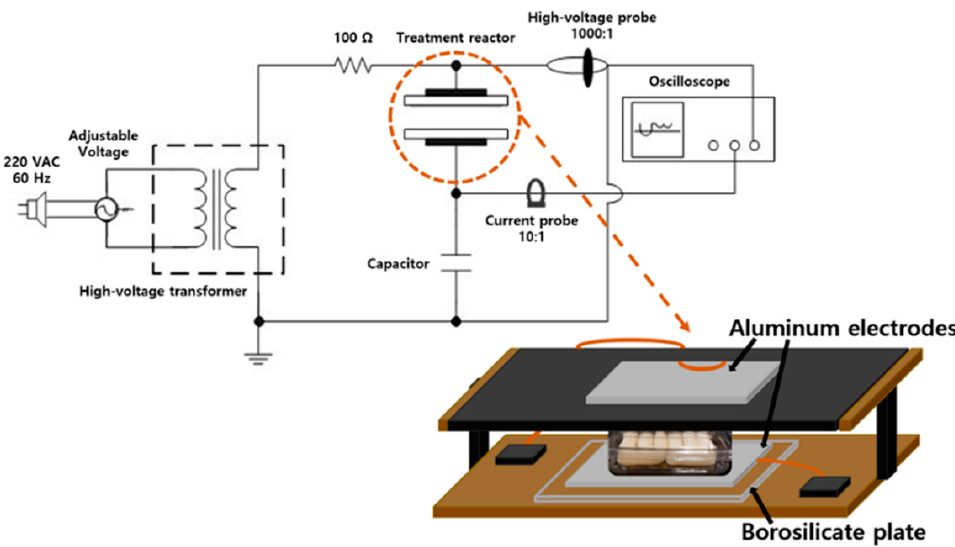
Figure 1. Schematic representation of in-package cold plasma treatment system used in this study. After placing a KRC-packaged PET container between the two electrodes, plasma was applied at 26 kV. This voltage was the maximum processing voltage not resulting in dielectric breakdown in KRC (data not shown). The distance between the upper surface of the packaging material and upper electrode was 0.5 cm. To investigate the effect of the location of KRC within the package on the inactivation of natural bacteria, KRC samples were placed in different configurations, as shown in Figure 2A, and treated with CP for 3 min without shaking. To evaluate the effect of a shaking step on the microbial inactivation efficiency, the 8-piece-KRC-containing PET package was shaken horizontally for 15 s (~0.5 hertz) every 45 s during the 3-min CP treatment period. CP treatment was performed for 1, 2, 3, 4, and 5 min with shaking using the 8-KRC package to investigate the effect of treatment time on microbial inactivation. To evaluate the effect of the number of KRCs per package on the inactivation of natural bacteria, packages including 4, 8, or 12 KRC pieces, as shown in Figure 2B, were subjected to CP treatment for 3 min with shaking. In all experiments, the package was kept unopened at 4 ◦ C for 1 h after CP treatment. After incubation, the microorganisms were enumerated and the physicochemical properties of KRC were analyzed. An infrared thermometer (DT 44L; DIAS Infrared GmbH, Dresden, Germany) was used to measure the surface temperature of KRC before and after CP